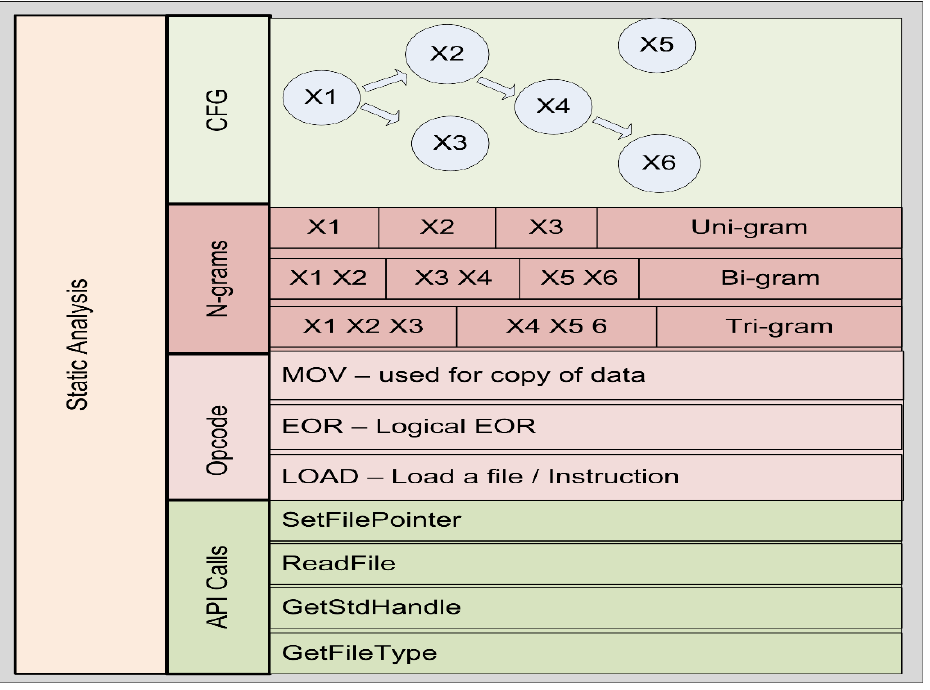
Figure 2. Approaches to static analysis. Table 1. Windows-supported APIs.